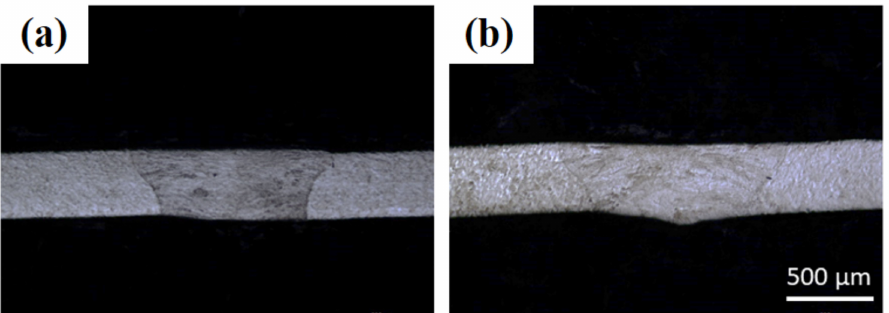
Figure 8. Optical images of 0.4 mm thick sheets’ laser weld cross-sections without powder addition and with laser power = 1000 W, gas flow rate = 5 slpm, robot tilt angle = 0 ◦ , and laser scanning speed = 3.0 m/min: ( a ) focal plane + 5 mm and ( b ) focal plane + 10